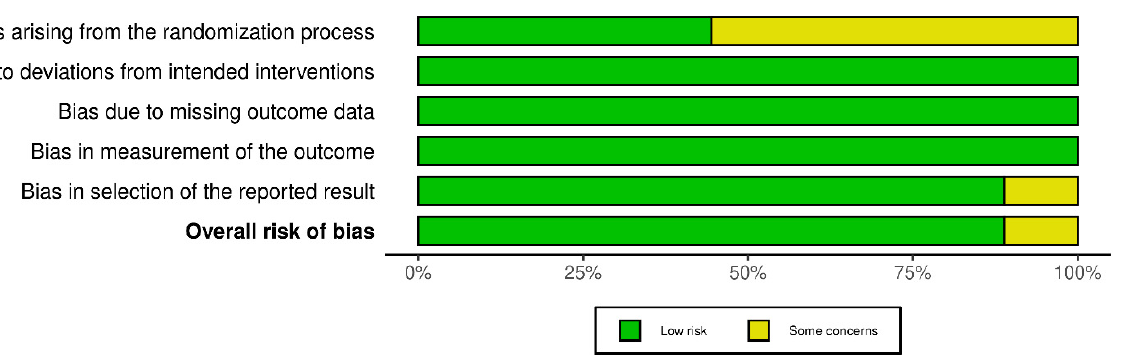
Figure 5. Overall Risk of Bias (Randomized Controlled Crossover Studies).